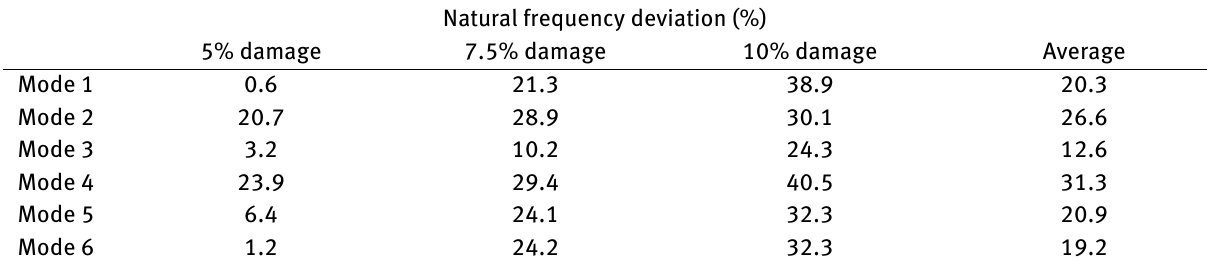
Table 3: Natural frequency deviation (%) of the ship sandwich plate in the first sixth